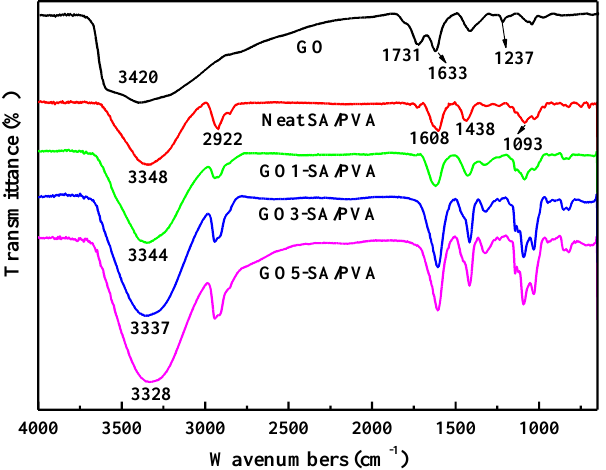
Figure 2. FTIR spectra of GO, DN hydrogel, and DN hydrogels with different GO loadings.